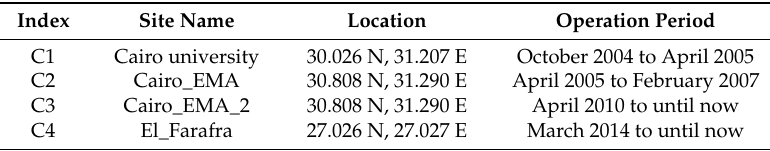
Table 3. Aerosol Robotic Network (AERONET) sites in Egypt.